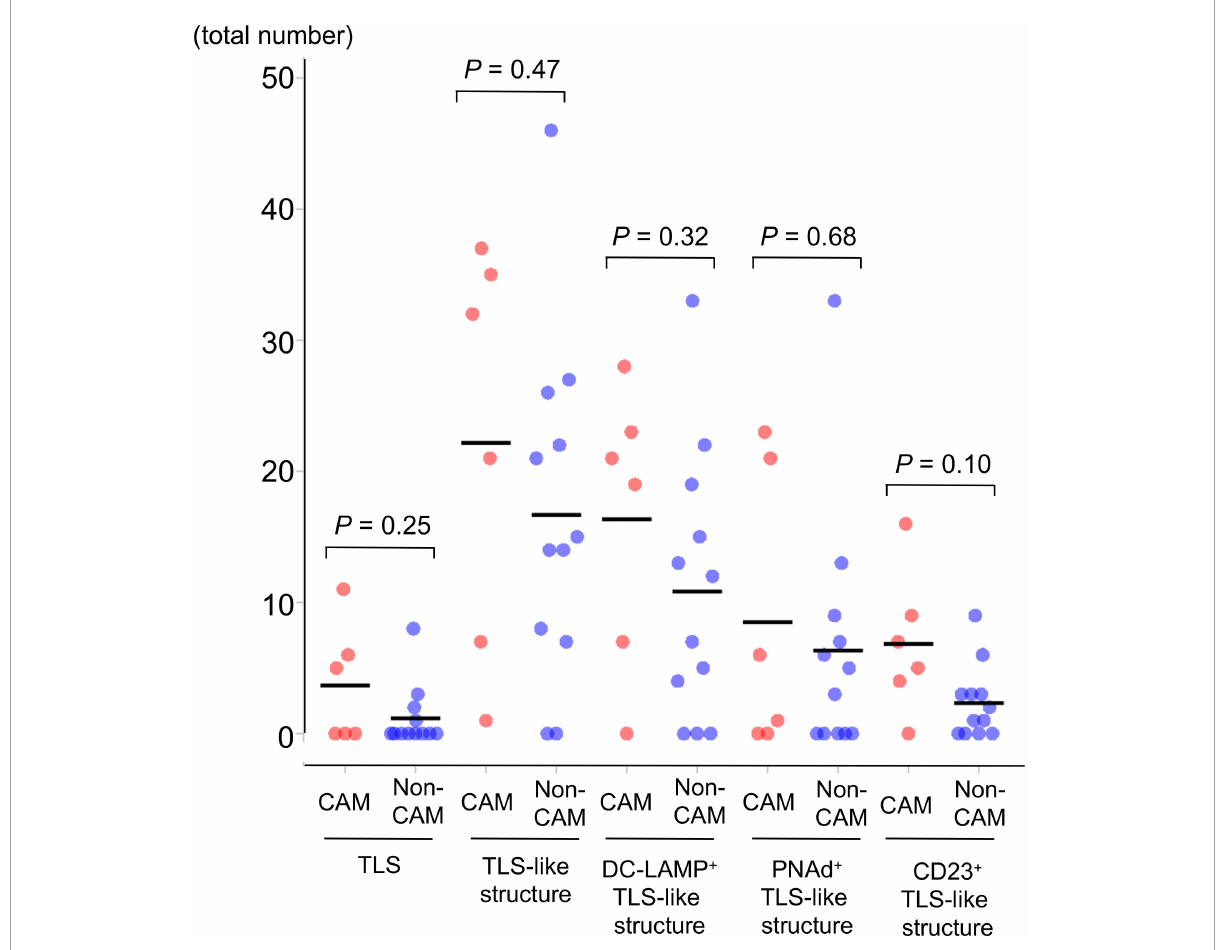
FIGURE3 The number of TLSs and TLS-like structures in 6 CAM patients and 12 non-CAM controls. The number of TLSs, TLS-like structures, DC-LAMP + TLS-like structures, PNAd + TLS-like structures, and CD23 + TLS-like structures was analyzed by computerized quantitative assessment using the bioimage analysis software QuPath. The horizontal lines denote the mean. TLSs, tertiary lymphoid structures; TIL, tumor-infiltrating lymphocyte; CAM, cancer-associated myositis; DC-LAMP, dendritic cell lysosomal associated membrane glycoprotein; PNAd, peripheral node addressin.